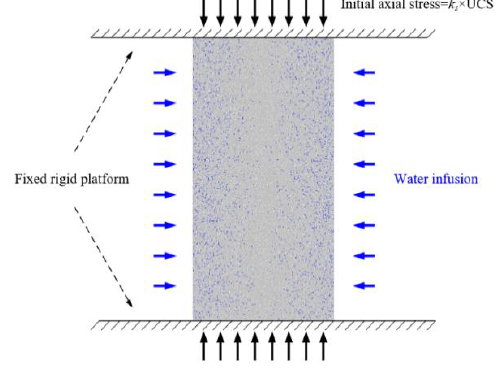
Figure 4. Sketch of the numerical model.